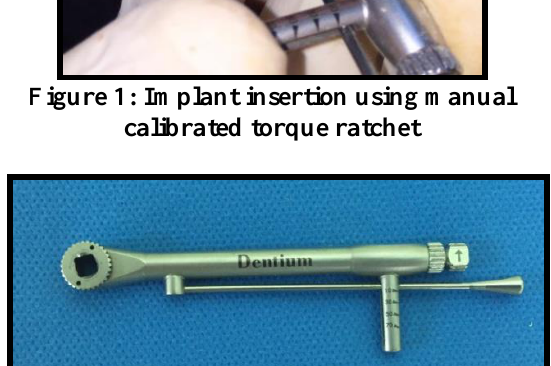
Figure 2: Manual calibrated torque ratchet with torque scale(10-70N/cm) (Dentium Co.,